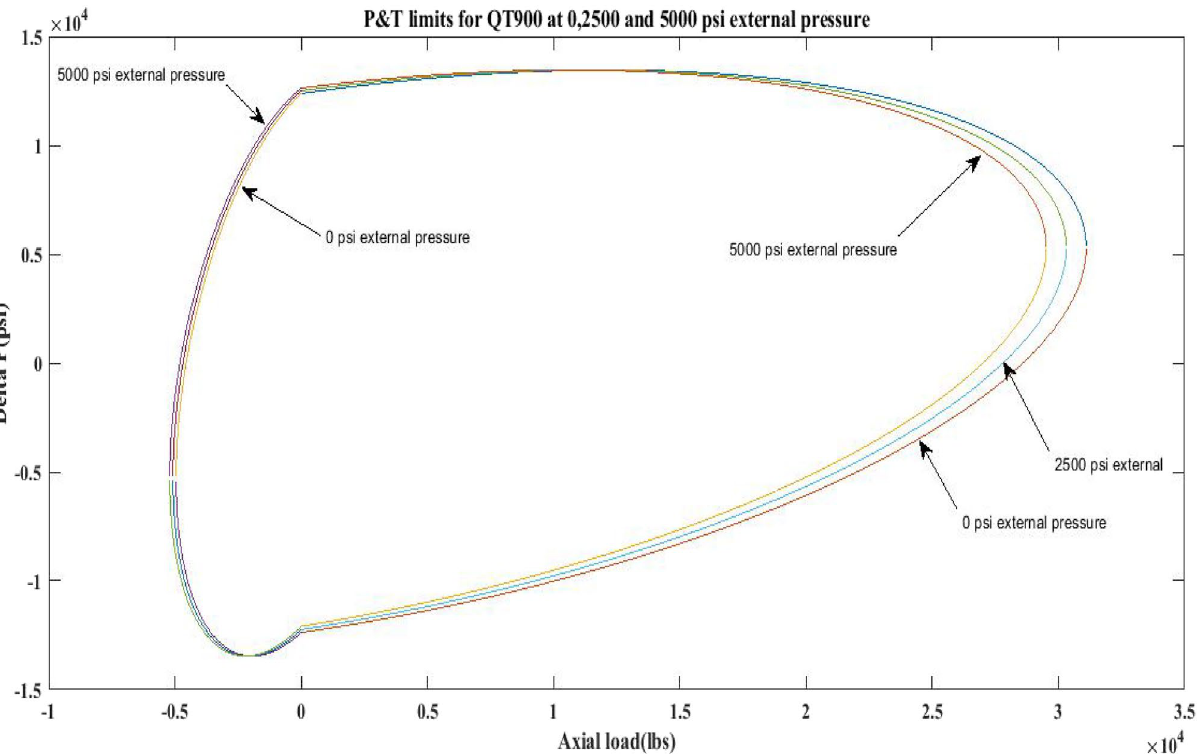
Figure 3. Pressure & Tension limits for QT 900 at 0, 2500 psi and 5000 psi external pressures.